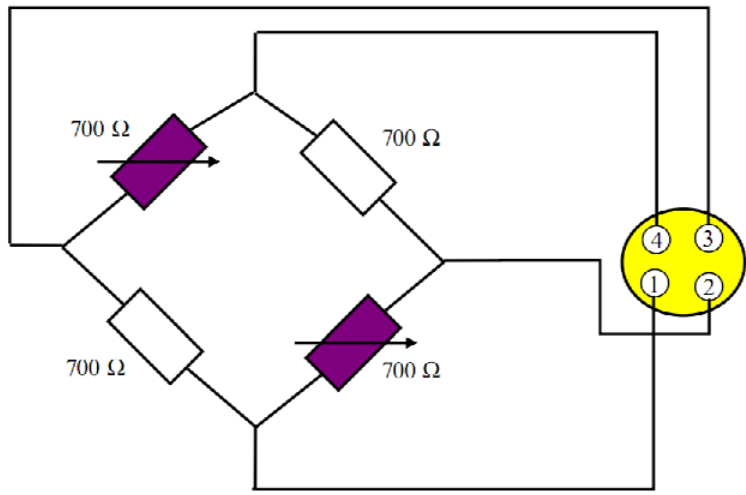
Figure 6. Measuring principle of the PZT stack position using SGS